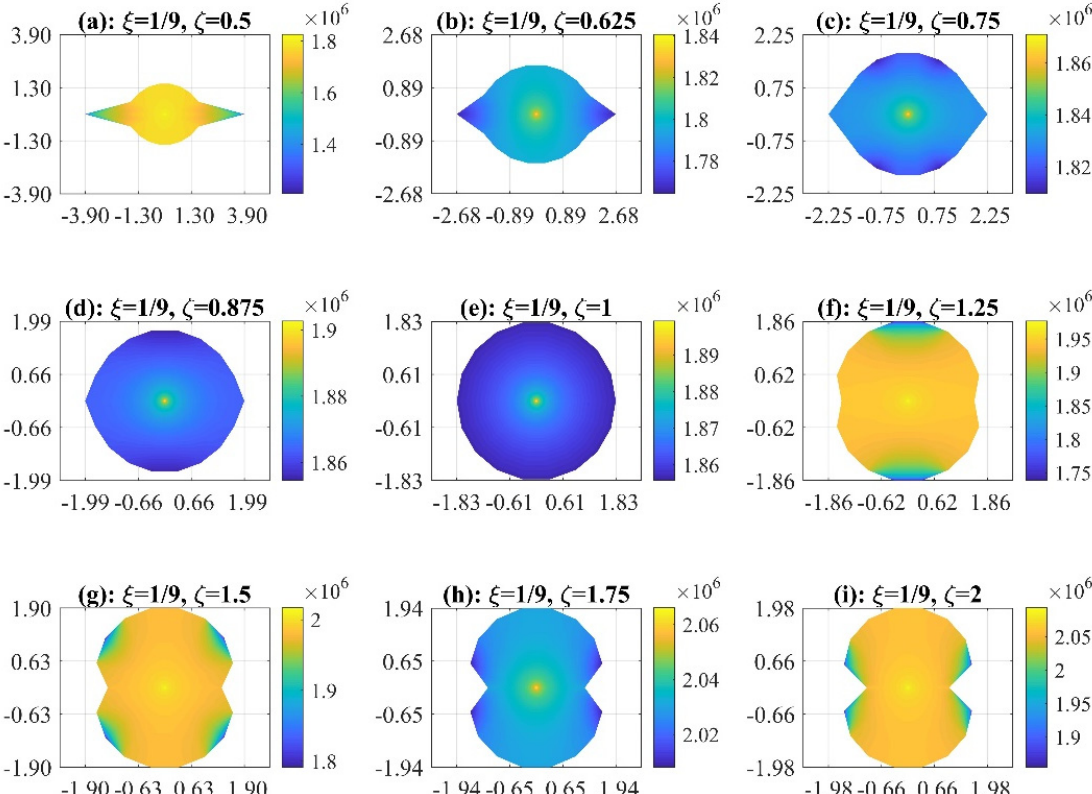
Figure 6. Distributions of fluid pressure of Group 1 numerical experiments ( ξ = 1/9) with 9 different fracture toughness contrasts at the moment = 20 s .